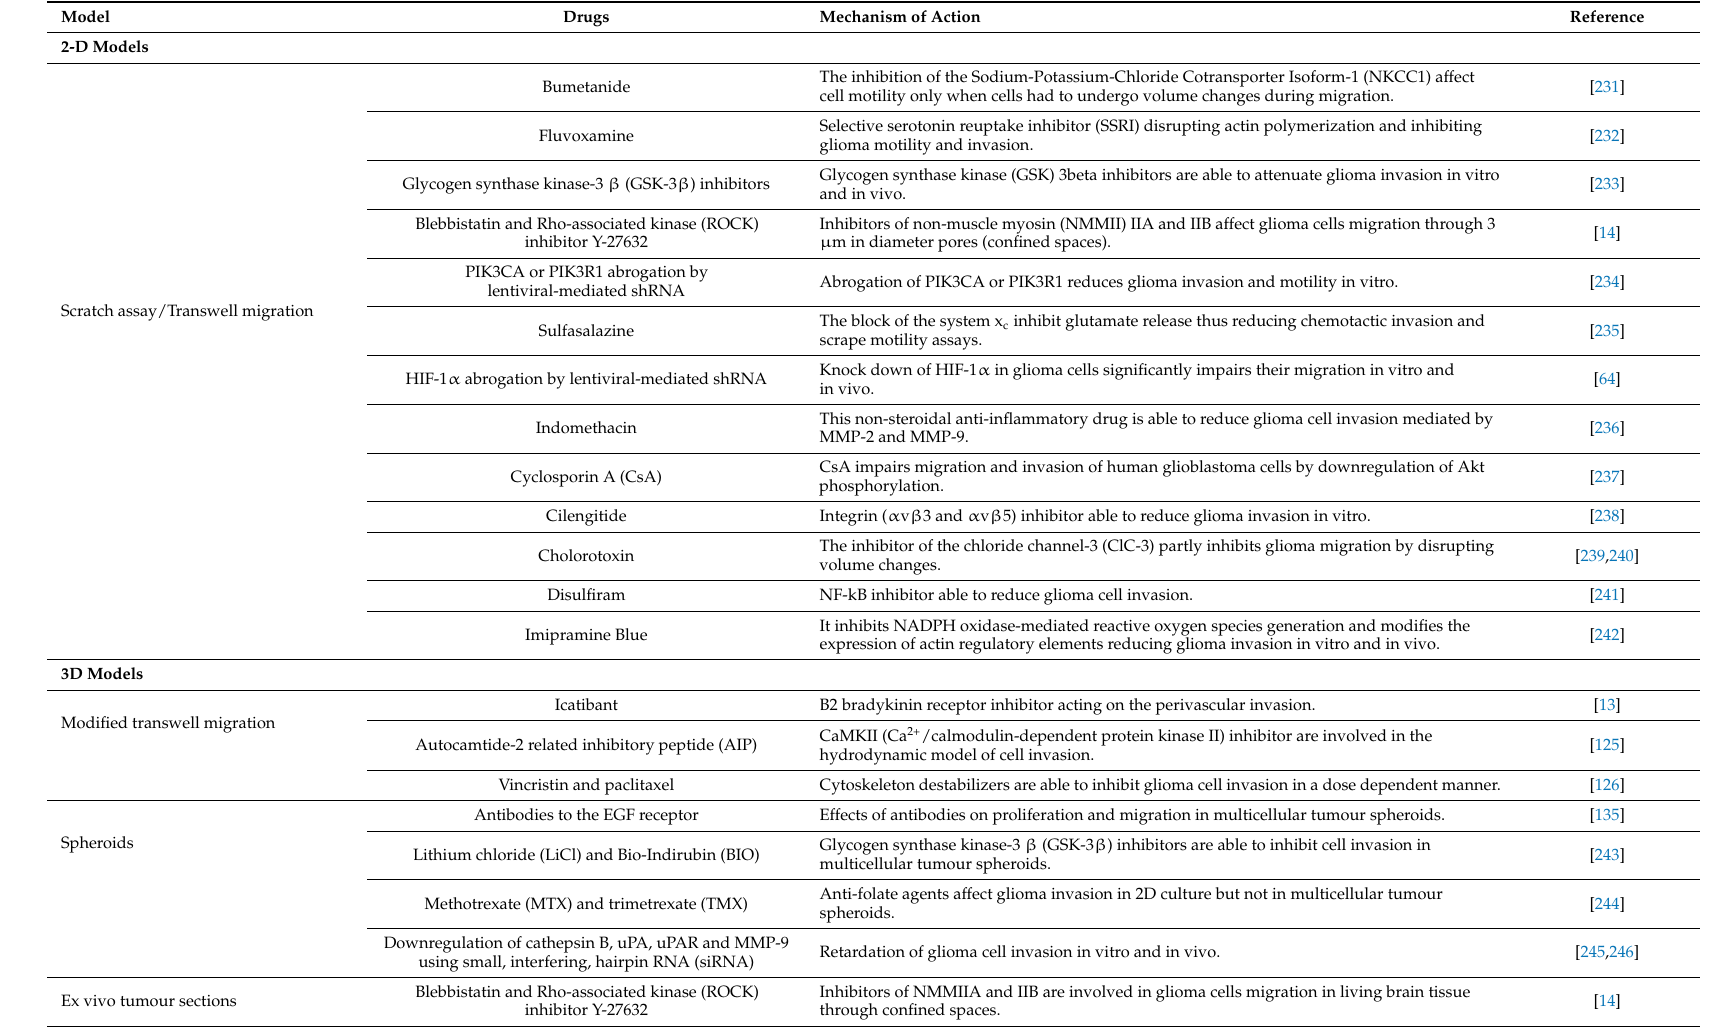
Table 2. Use of in vitro models to assess new therapeutic strategies interfering with glioma